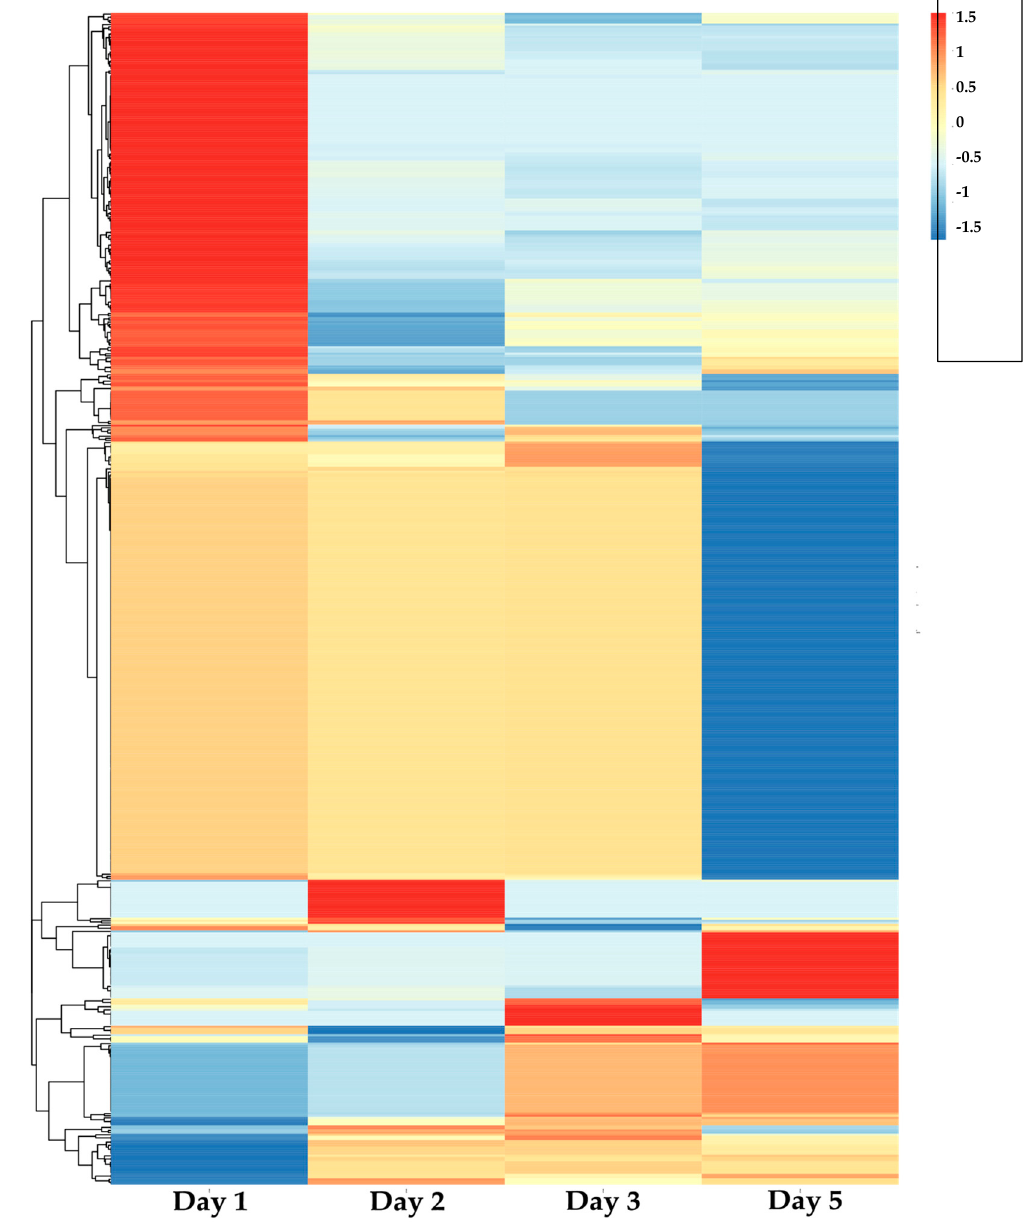
Figure 5. The flux distribution of NXJ-24 mutant during different fermentation process. The rows represent the reactions in the Asmp 1282.